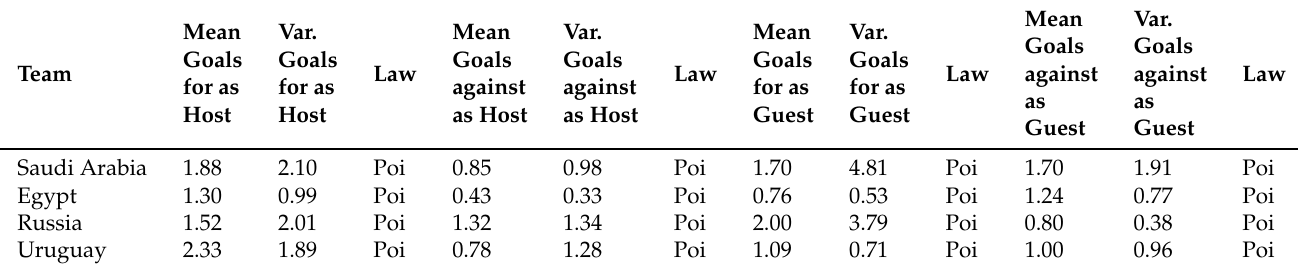
Table 6. Group A in Russia 2018.